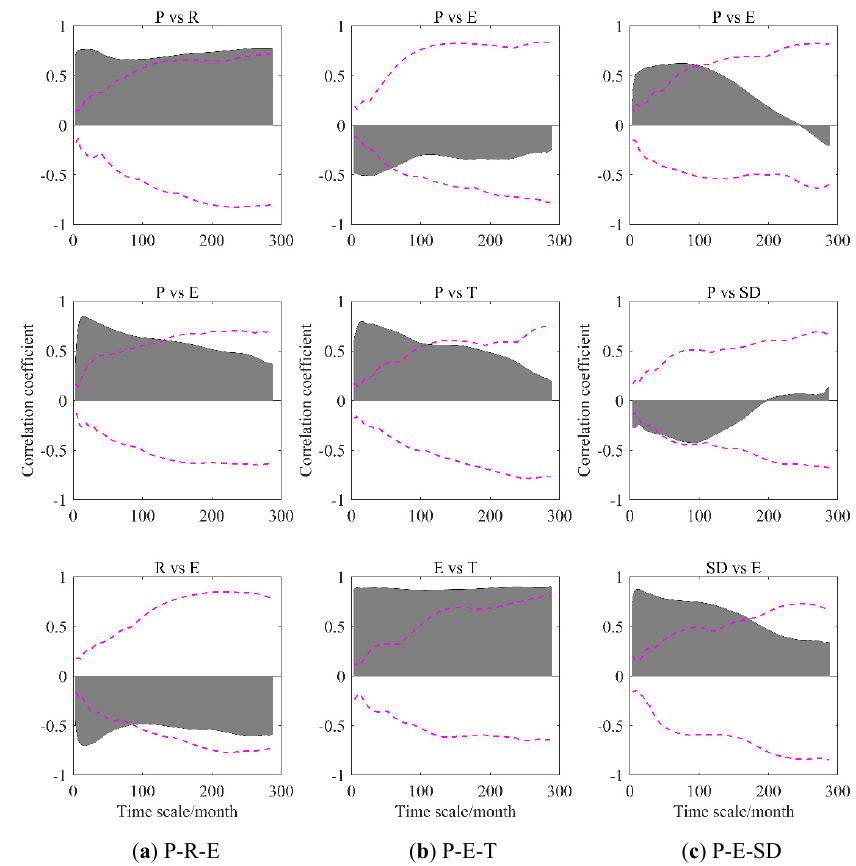
Figure 6. Significant tests of partial cross-correlation coefficients in a three-element-composed system, i.e., P-R-E ( a ), P-E-T ( b ), and P-E-SD ( c ). The upper (or lower) envelope of the black area is DPCCA